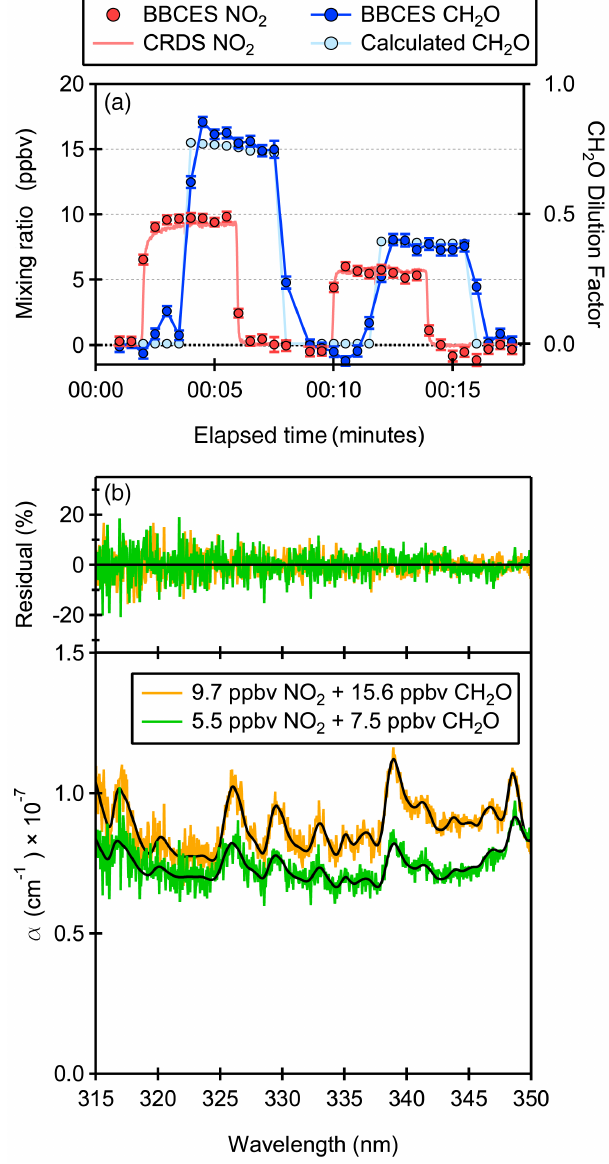
Figure 7. (a) Time series of 30s measurements of sequential addi- tions of 9.7ppbv NO 2 , 15.6 CH 2 O, 5.5ppbv NO 2 , and 7.5 CH 2 O during a 17min period. BBCEAS NO 2 and CH 2 O concentrations are compared to CRDS NO 2 concentrations and calculated CH 2 O dilution factors. (b) Measured α(λ) and calculated spectral fits for 30s measurements with different CH 2 O and NO 2